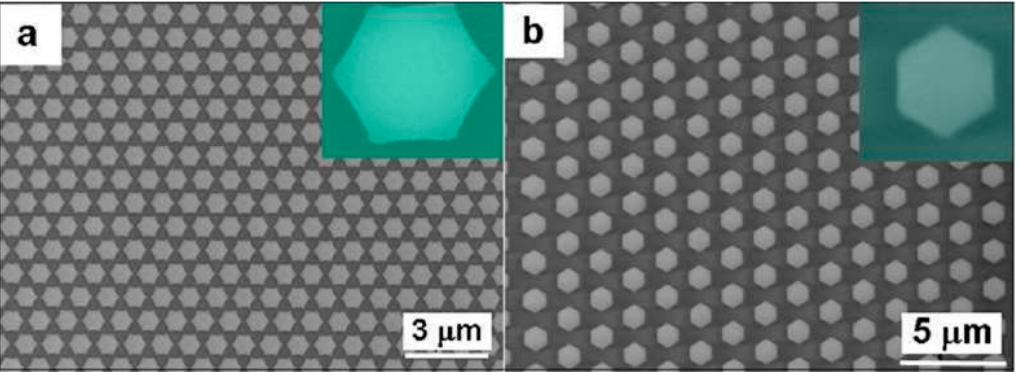
Figure 6. The morphology after Ar + plasma etching the heated PS monolayer for enough time. ( a ): The SEM image of the heated PS monolayer with 1 µ m in PS sphere’s diameter after etching for 12 min. ( b ): The SEM image of the heated PS monolayer with 2 µ m in initial PS sphere’s diameter after etching for 15 min. The insets are the magnified images of the single etched PS spheres. (100 W in input power for etching).